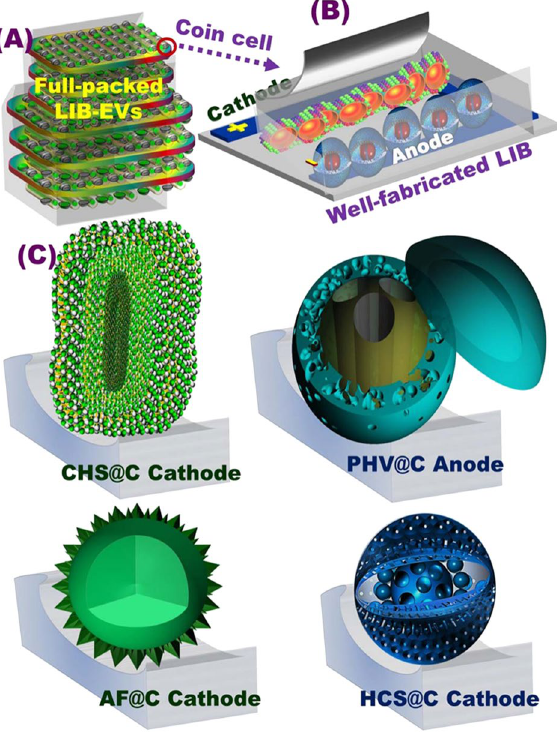
Figure 1. ( A ) Full-packed 18650 cylindrical cells of AF@C//PHV@C full-scale coin cells for creating rechargeable LIBs for EVs. The EV pack was formed via the connection of several built-in modules in a series of LIB 2032 coin cells. The module was designed by connecting a number of LIB coin cells characterized by similar voltages and capacities, to a certain extent, in (i) series (S) and (ii) parallel (P) directions; ( B ) formulation and well-defined fabrication of 3D orientation of meso-geodesic anode/cathode cuticles; 3D topographical hierarchy ridges, surface interfaces, and vortices designated in CR2032 coin cells influencing the power tendency of LIBs in terms of high energy density and power density; ( C ) 3D projections of structurally shaped LFPO hollow spheroid hierarchy (cathode) and anatase TiO 2 @C of multi-hole spheres (PHV@C, anode) represented according to the FE-SEM and HRTEM microscopic patterns of AF@C with hollow-geode cavity and needle dendrites along the 3D anisotropic hollow surfaces, HCS@C, and CHS@C cathodes, in addition to the integrated anatase TiO 2 @C spheres decorated with PHV@C anode in full-scale